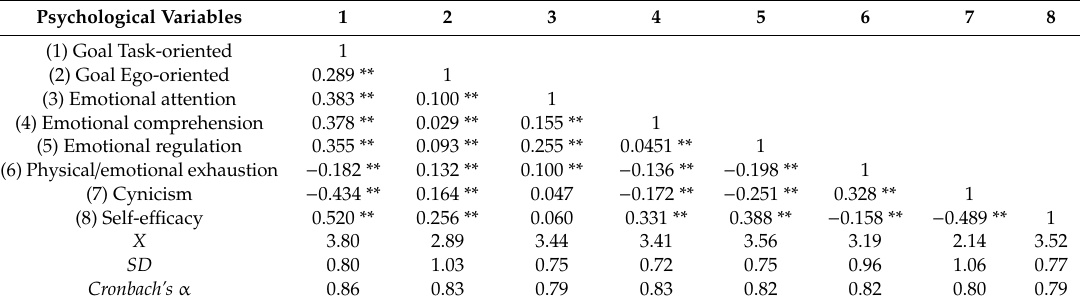
Table 3. Goal orientation, emotional intelligence, and academic burnout correlation analysis. Psychological Variables